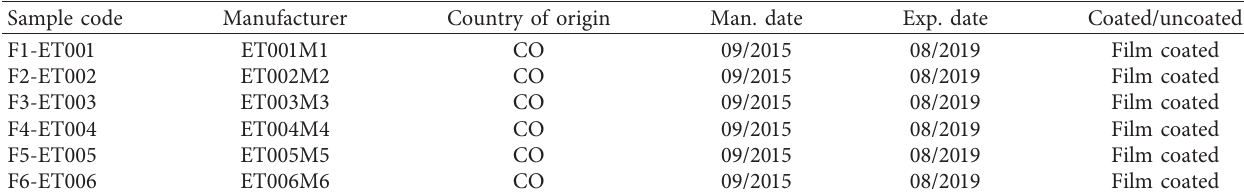
Table 1: Some information of ethambutol hydrochloride 100mg tablet batches tested. Sample